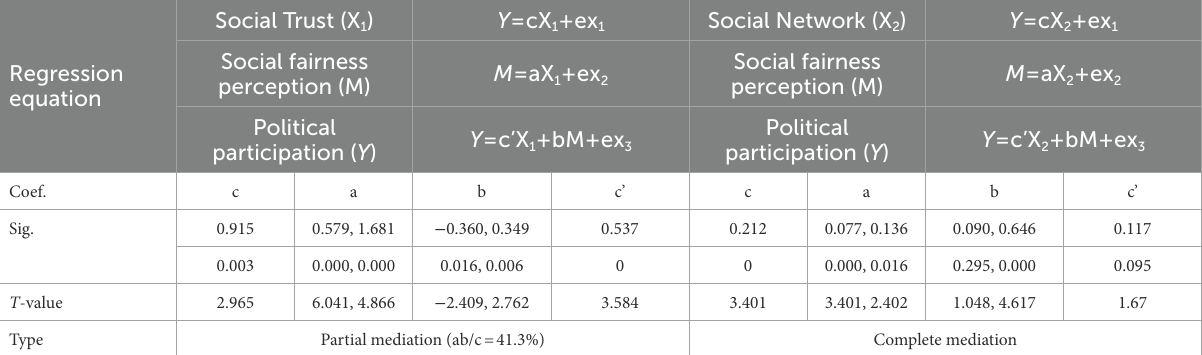
TABLE 5 Results of the mediating effect test.